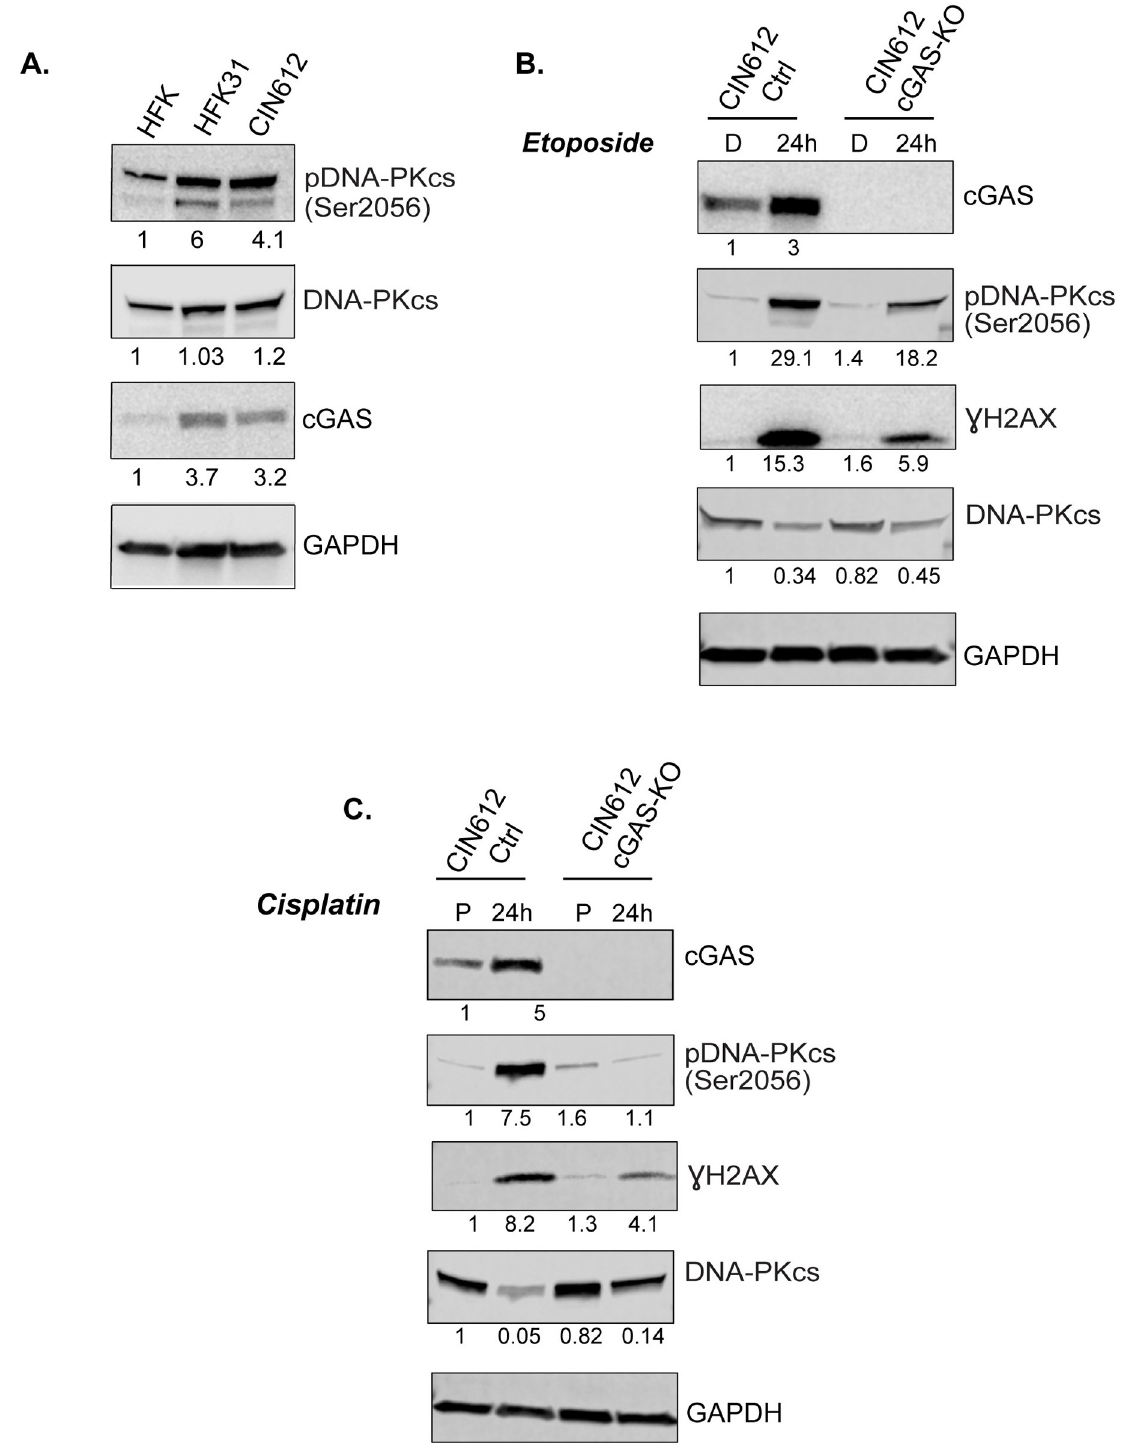
Fig 9. pDNA-PK levels are decreased in absence of cGAS. (A) Western blot analysis of total and phosphorylated DNA-PKcs levels in HFKs, HFK-31 and CIN612 cells. CIN612 pLenti control and cGAS-KO cells were screened for levels of cGAS, DNA-PKc, pDNA-PKc Ser2056 and γ H2AX following treatment with etoposide (50 μ M) (B) and cisplatin (5 μ M) (C) for 24hrs. Densitometry values were determined using ImageJ.